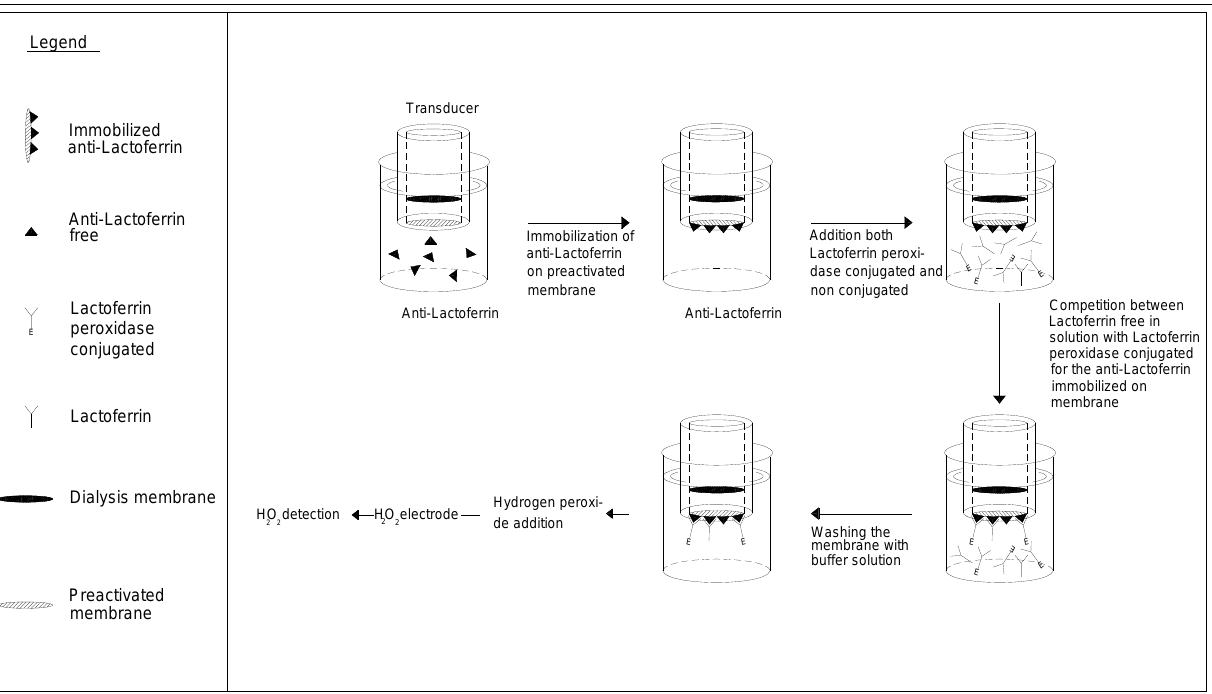
Figure 3. Determination of lactoferrin by immunosensor, Test geometry: competition between lactoferrin biotin-avidin-peroxidase conjugated and lactoferrin, both free in solution for Anti-lactoferrin immobilized in